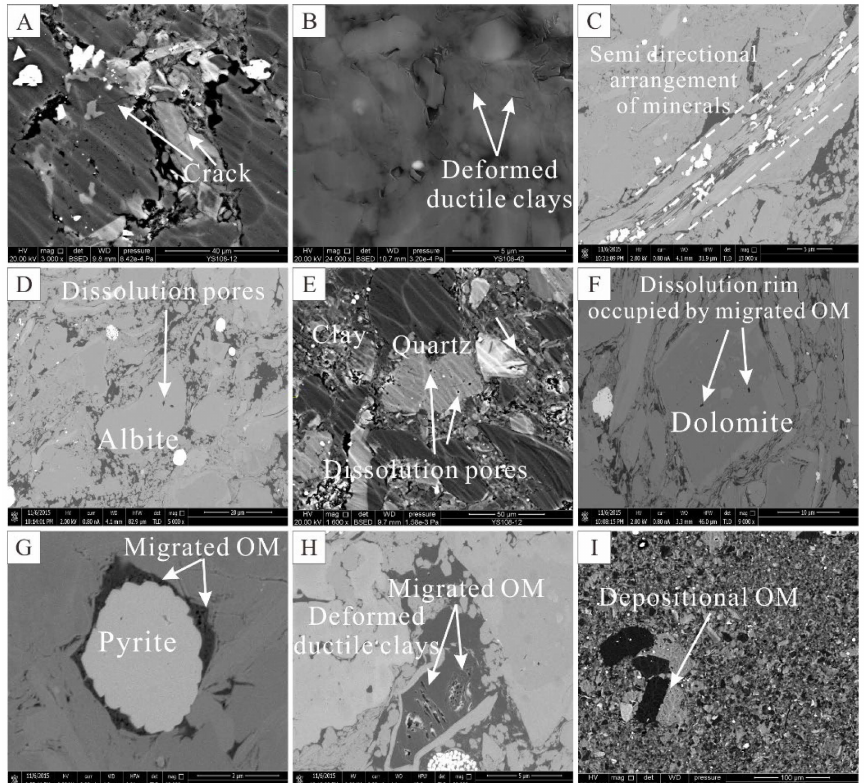
Figure 10. FE-SEM images of Wufeng-Longmaxi Fm shale within pore types formed during diagenetic evolution. ( A ) Cracks formed under mechanical compaction; ( B ) The ductile deformation of clay minerals under mechanical compaction; ( C ) Directional arrangement of minerals under mechanical compaction; ( D ) Dissolution pores in albite under dissolution; ( E ) Dissolution pores in quartz under dissolution; ( F ) Dissolution pores in dolomite under dissolution; ( G ) Organic matter pores in migrating organic matter; ( H ) The ductile deformation of clay minerals under mechanical compaction and organic matter pores; ( I ) Depositional organic matter